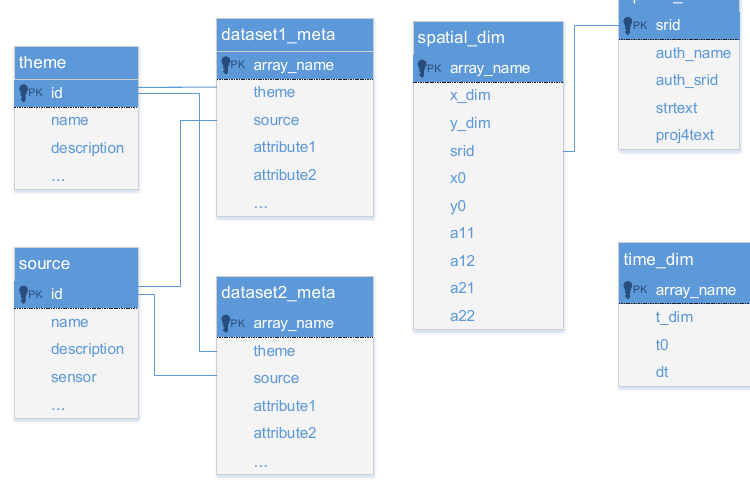
Figure 3. ER model for EO